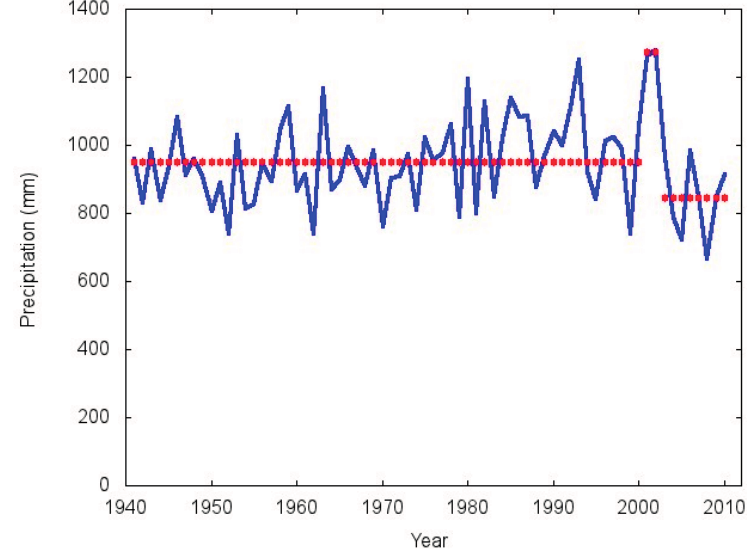
Figure 8. Annual precipitation and means for the 1941–2010 period in the Flooding Pampa